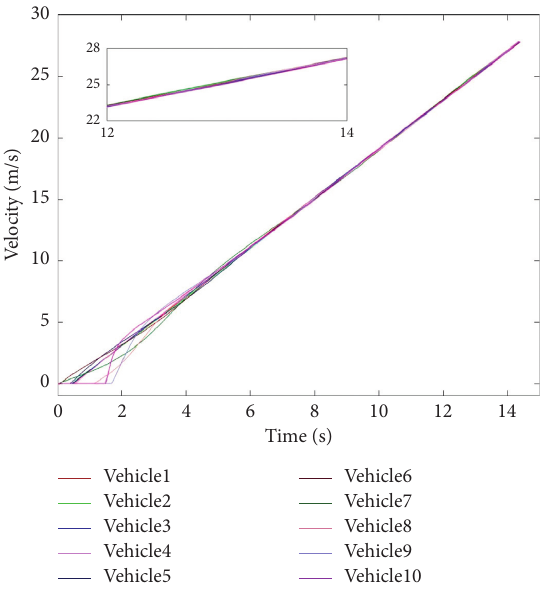
Figure 9: Velocity history under proposed controller (41).